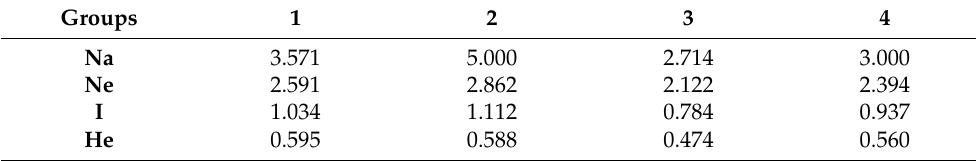
Figure 2. STRUCTURE analysis bar plot of the 58 opium poppy accessions for the runs with highest likelihood out of 20 runs for cluster K = 4. 58 bars represent the 58 accessions broken into different colored genetic clusters. The height of each color within a bar corresponds to the probability of assignment to one of the genetic clusters. Accessions that share the same colors are more similar. Table 5. Genetic indices for the four groups obtained by STRUCTURE analysis.